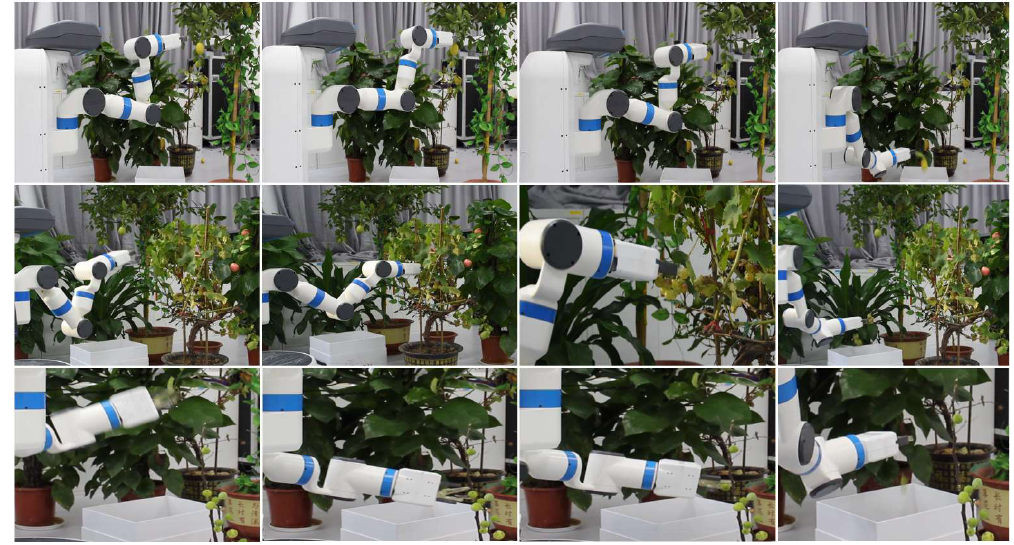
Figure 14. Video frames showing robot harvests real lemons (top), grapes (middle), and common figs (bottom).